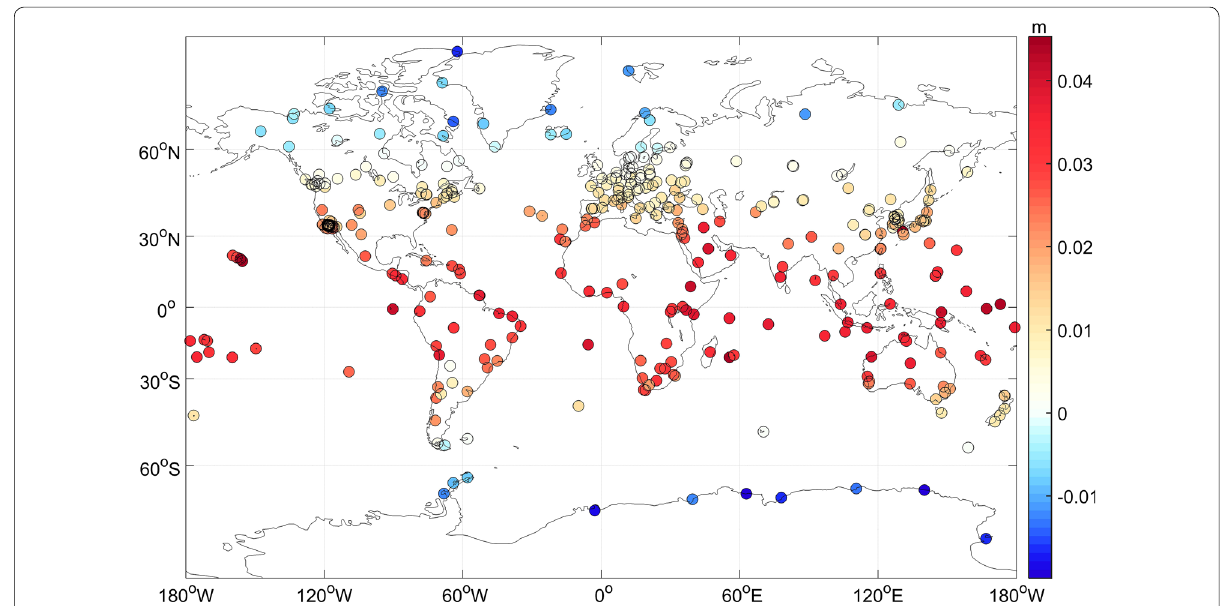
Fig. 10 Slant delay bias (m) at 3° elevation angle for the GPS DDA